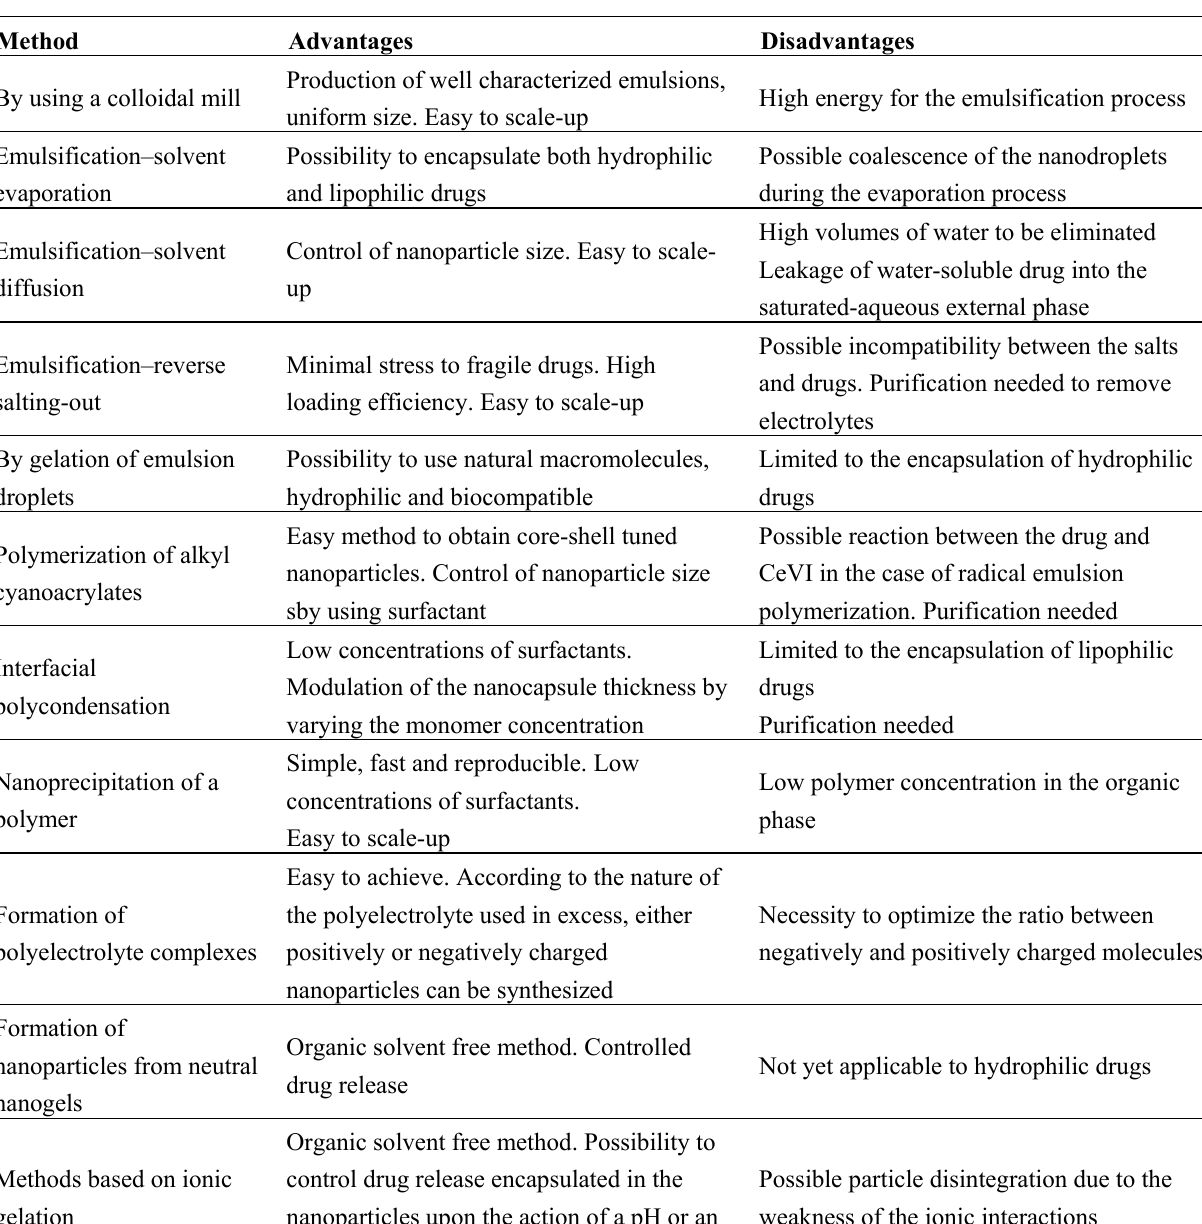
Table 3. General advantages and disadvantages of the nanoparticle preparation methods. With kind permission from Springer Science+Business Media: Pharmaceutical Research , Methods for the Preparation and Manufacture of Polymeric Nanoparticles, 26 , 2009 , 1049, Christine Vauthier and Kawthar